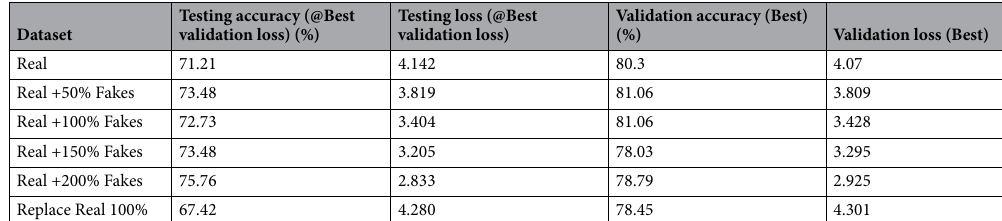
Table 4. Accuracy scores and losses for each dataset used for augmentation and anonymization.